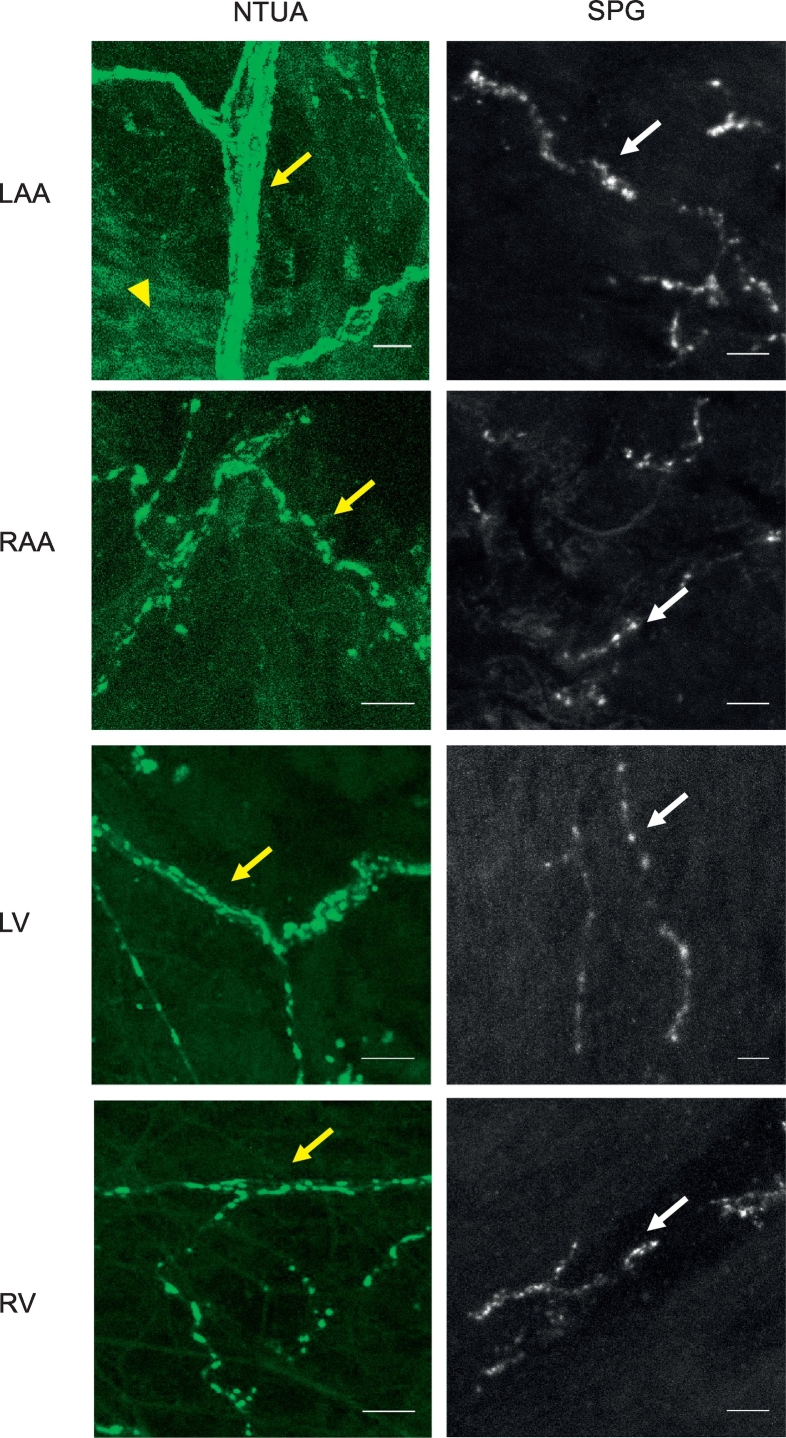
NTUA and SPG labelling of noradrenergic nerves in the rat heart. NTUA labelling (left panels) and glyoxylic acid-induced histofluorescence (SPG; right panels) of each chamber of the rat heart, i.e. left atrial appendage (LAA), right atrial appendage (RAA), left ventricle (LV) and right ventricle (RV). NTUA labelled noradrenergic axonal bundles can be seen dividing off into single fibre axons with punctate swellings of nerve terminals (yellow arrows). The latter was also seen by SPG histofluorescence (white arrows). Yellow arrow heads mark the presence of non-neuronal fluorescence in response to NTUA treatment.For all micrographs, bars = 10 μm.